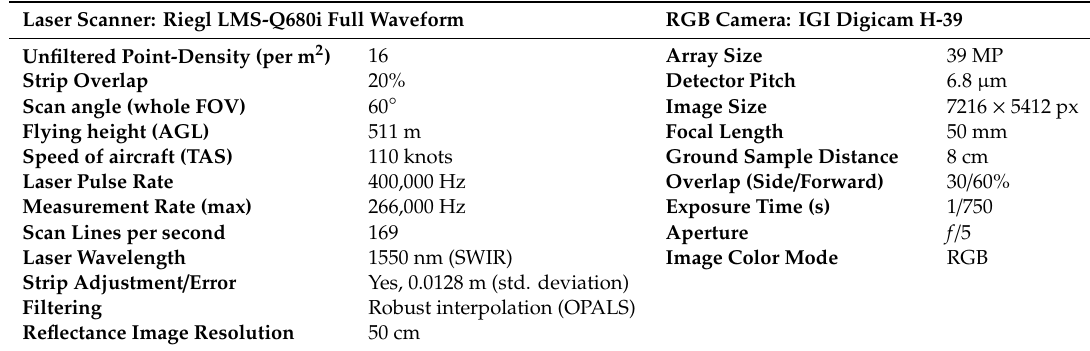
Table 1. ALS and orthoimage acquisition parameters. Acquisition date: 21 February 2016 0746-124. Source: Airborne Technologies, GmbH / Riegl Laser Measurement